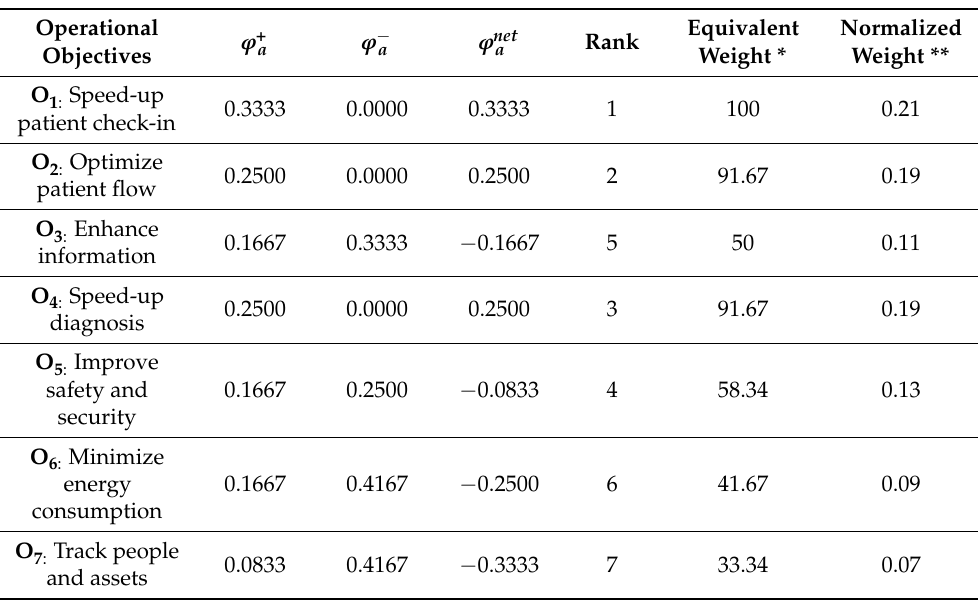
Table A4. The result of PROMETHEE performance flows and outranking of the clinic’s